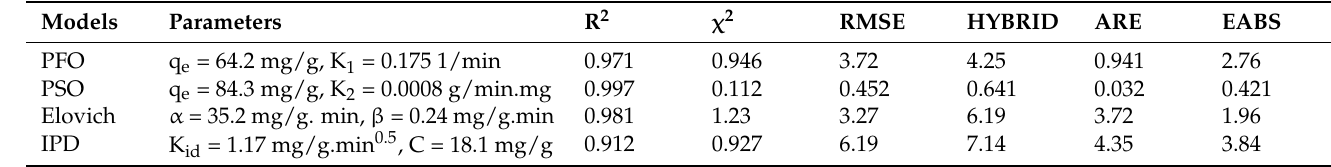
Figure 6. Nonlinear plot of kinetic models of FLX adsorption ( a ), IPD kinetics for FLX adsorption ( b ), by MWCNTs/CoFe 2 O 4. Table 1. Results of the kinetic parameters of Levofloxacin adsorption onto MWCNTs/CoFe2O4 nanocomposites.